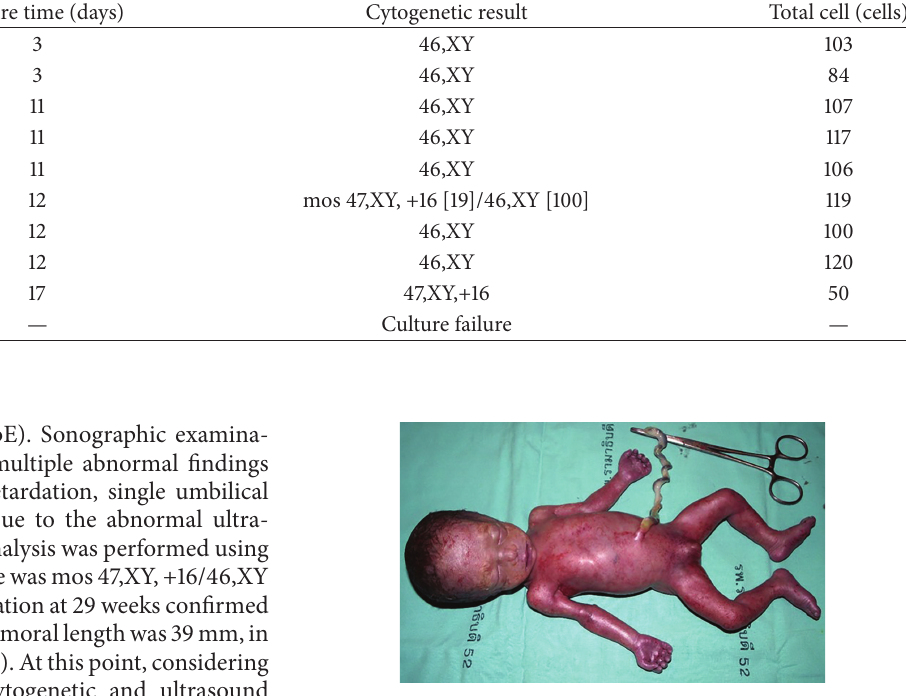
Figure 1: Gross anatomical description: the body of Thai male was symmetrical small for gestational age. The external appearance showed no dysmorphic feature. Contracture of hands and rocket bottom feet, genital hypoplasia, and small placenta with furcated cord insertion and single umbilical artery were